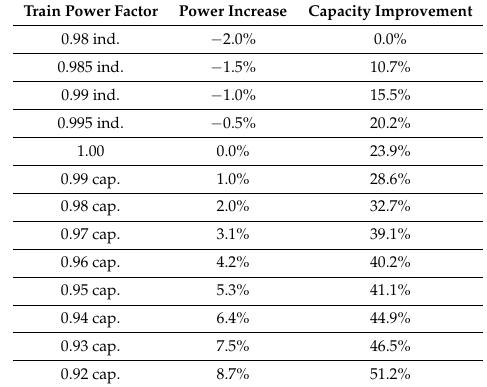
Table 4. Comparison of power factor with apparent power increase and average improvement of railway infrastructure